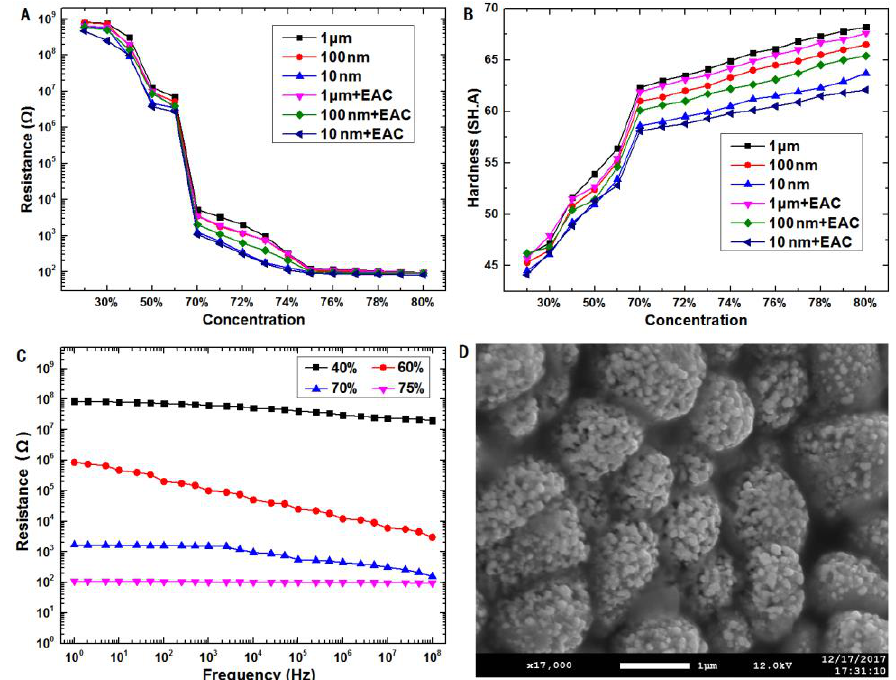
Figure 1. Effects of the Ag powder particle size and dispersion method on the ( A ) resistance and ( B ) hardness of the composite. ( C ) Alternating current (AC) electrical resistance of composite electrode with different mass ratio, mixed 10-nm Ag powder and polydimethylsiloxane (PDMS) using indirect dispersion. ( D ) Scanning electron microscopy (SEM) images of composite electrode (75% w / w ), mixed 10-nm Ag powder and PDMS using indirect dispersion.